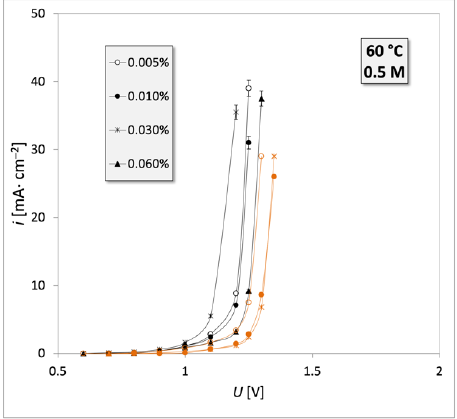
Figure 4. Electro-oxidation curves of Syntanol DS-10 detergent (orange lines) and waste engine oil emulsion (black lines) at the temperature of 60 ◦ C in a 0.5 M aqueous solution of H 2 SO 4 , for various concentrations of detergent and emulsion (0.005%, 0.010%, 0.030%, and 0.060% of reactor volume).